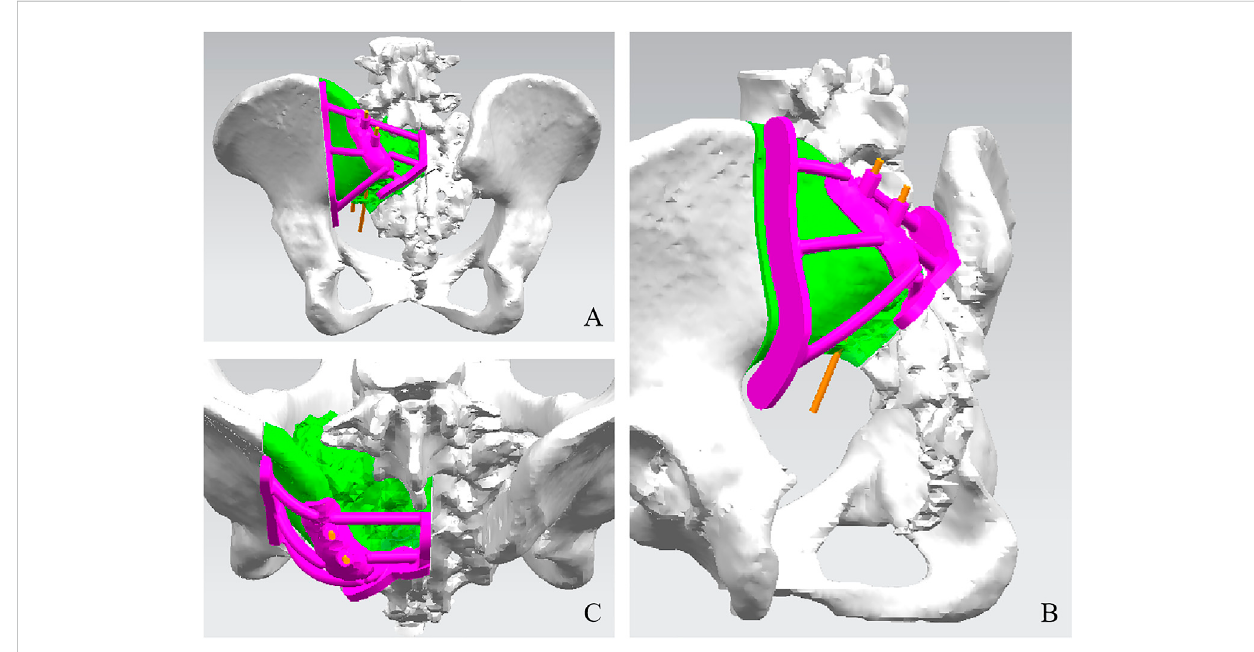
FIGURE 3 Design of the cutting guide. Dorsal view (A) , side view (B) , and front view (C) of the sacral implant 3D